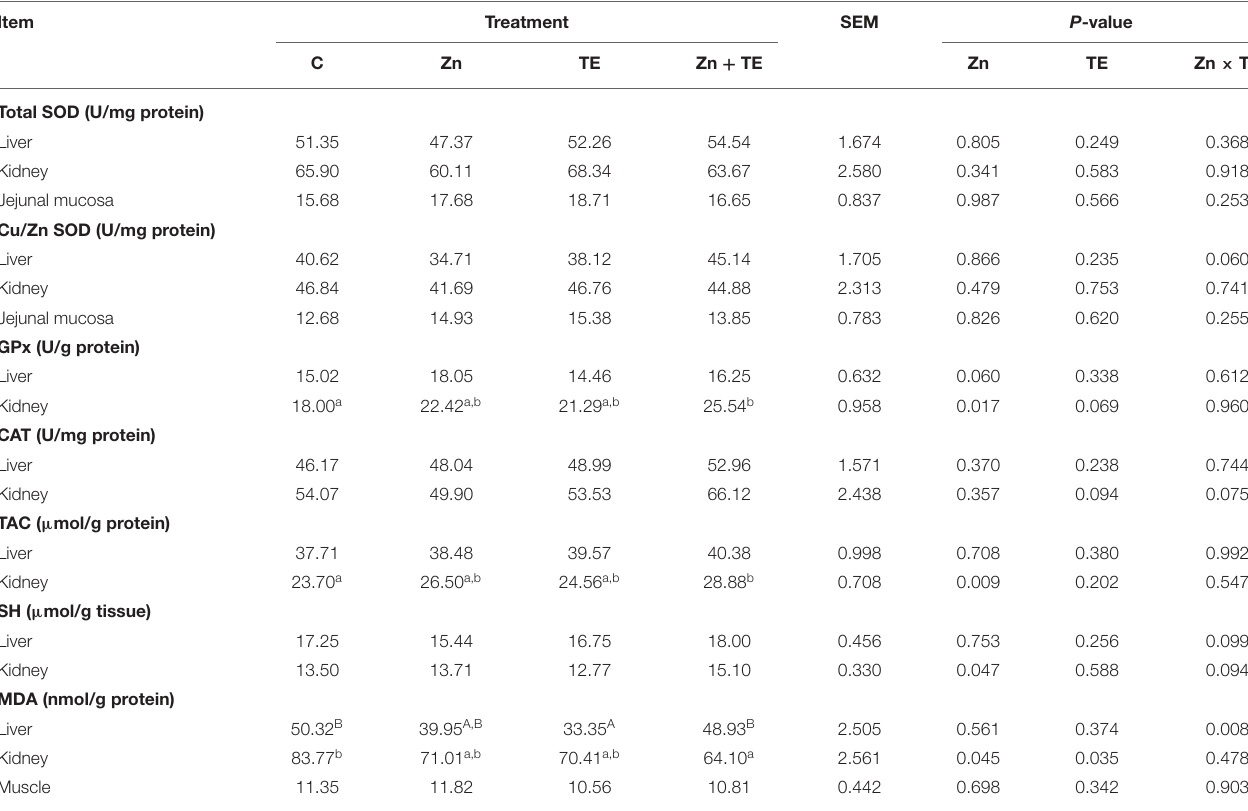
TABLE 4 | The effect of organic zinc and/or thyme extract administration on the antioxidant enzyme activities, total antioxidant capacity, total thiols level, and lipid peroxidation in the tissues of